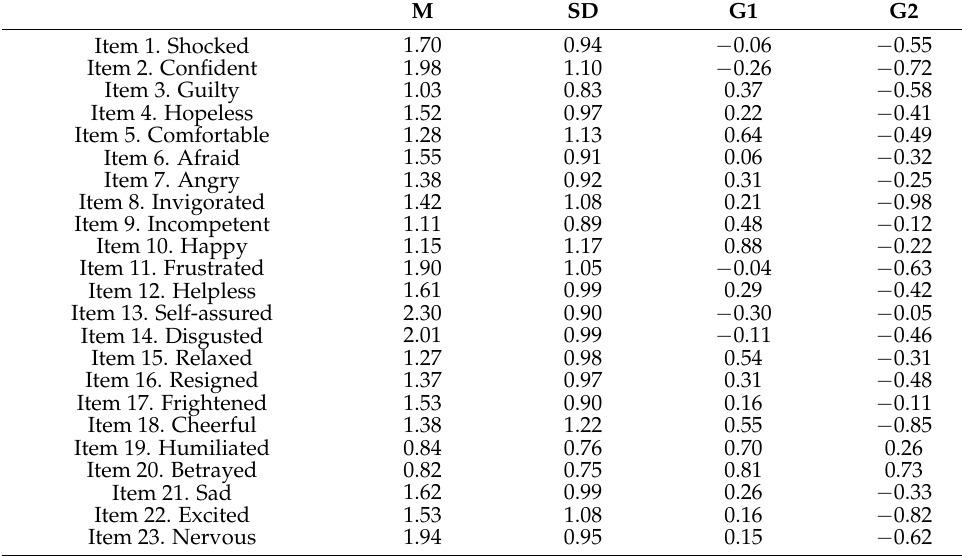
Table 1. Descriptive statistics for the items (N =